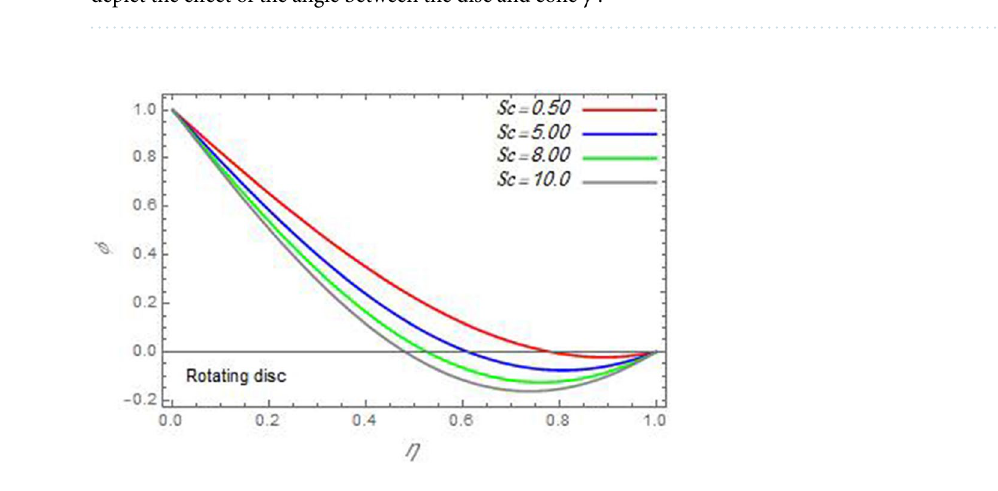
Figure 24. The nanoparticles volume fraction distribution ϕ is plotted versus the axial variable η in the case of stationary cone to depict the effect of the Schmidt number Sc